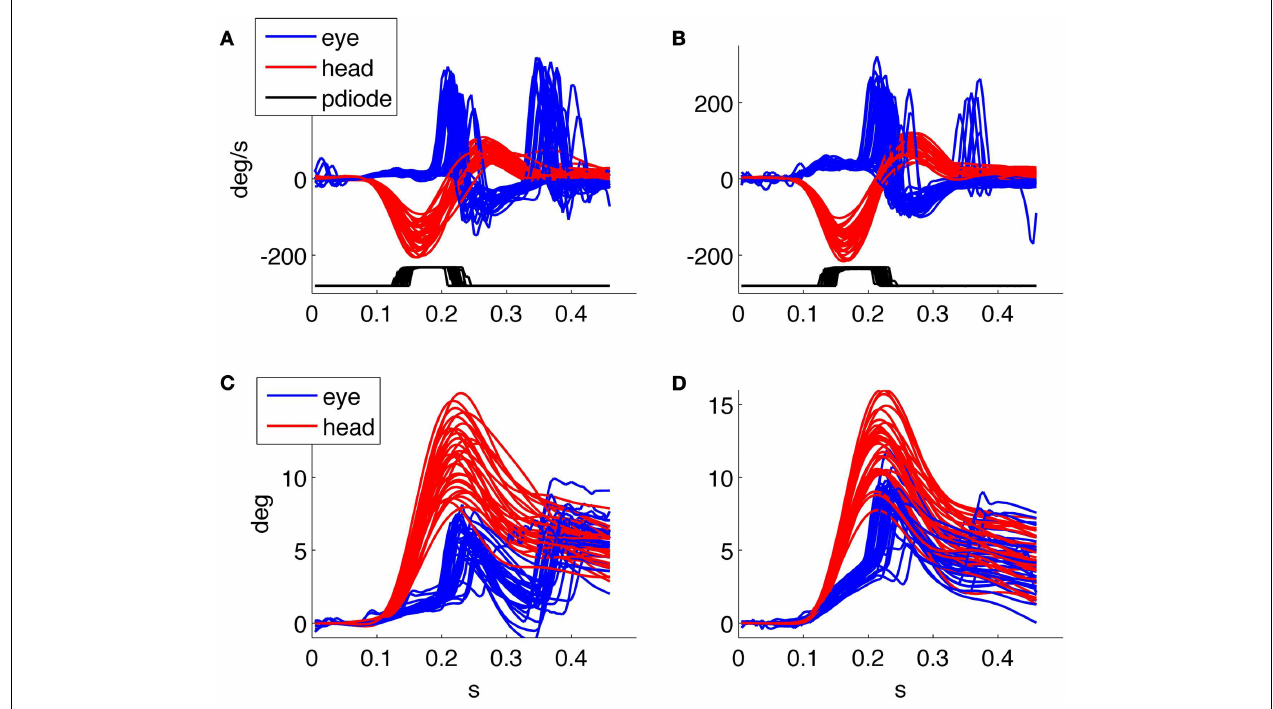
FIGURE 6 | Head impulse testing device test 3days (on the left) and 1month (on the right) after the acute phase of a vestibular neuritis . (A,B) velocity plot, (C,D) position plot.The patient improved the percentage of correct answers from 3 to 39%.